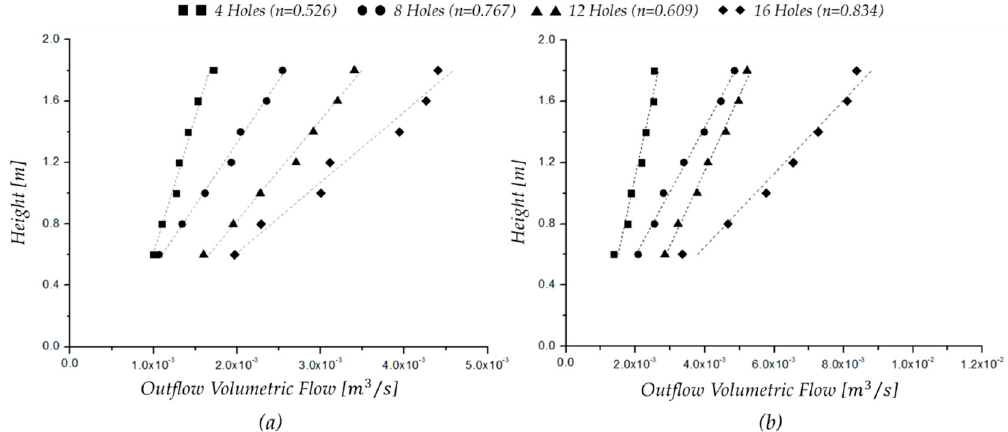
Figure 7. Outflow volumetric flow at different enclosure heights according to the number of leakage holes predicted by the existing and proposed theoretical equations: ( a ) IG-01 ; ( b ) HFC-125 .